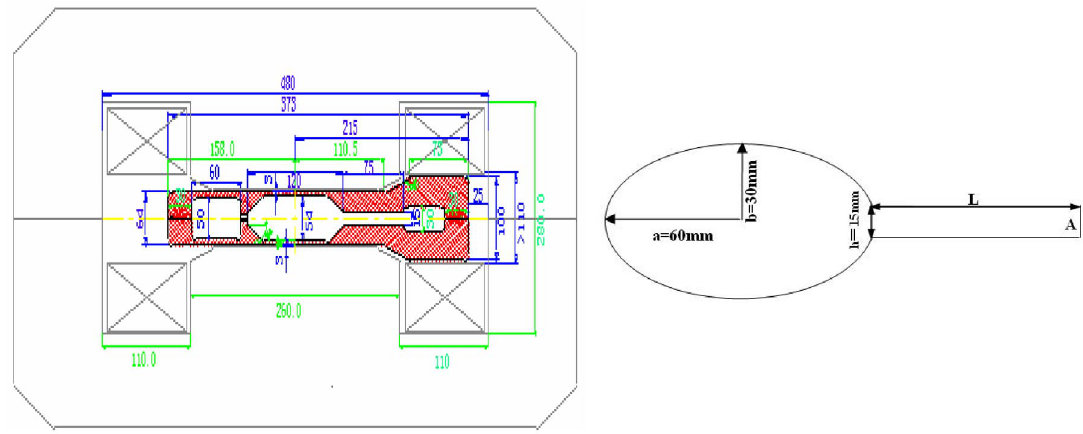
FIG. 12. (Color) The antechamber structure (left) and the simplified model used in the simulation